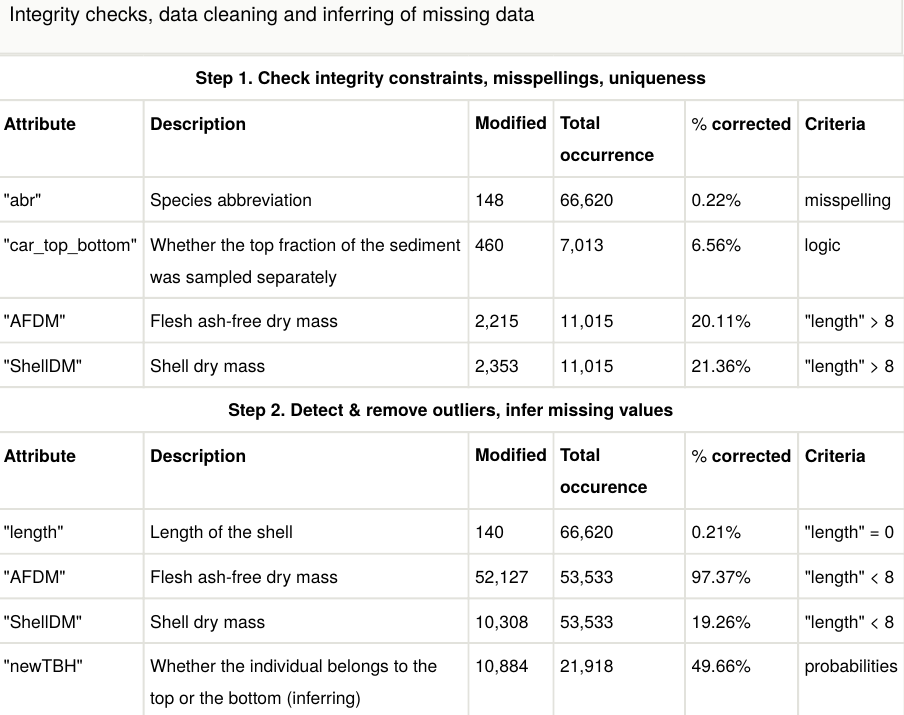
Integrity checks, data cleaning and inferring of missing